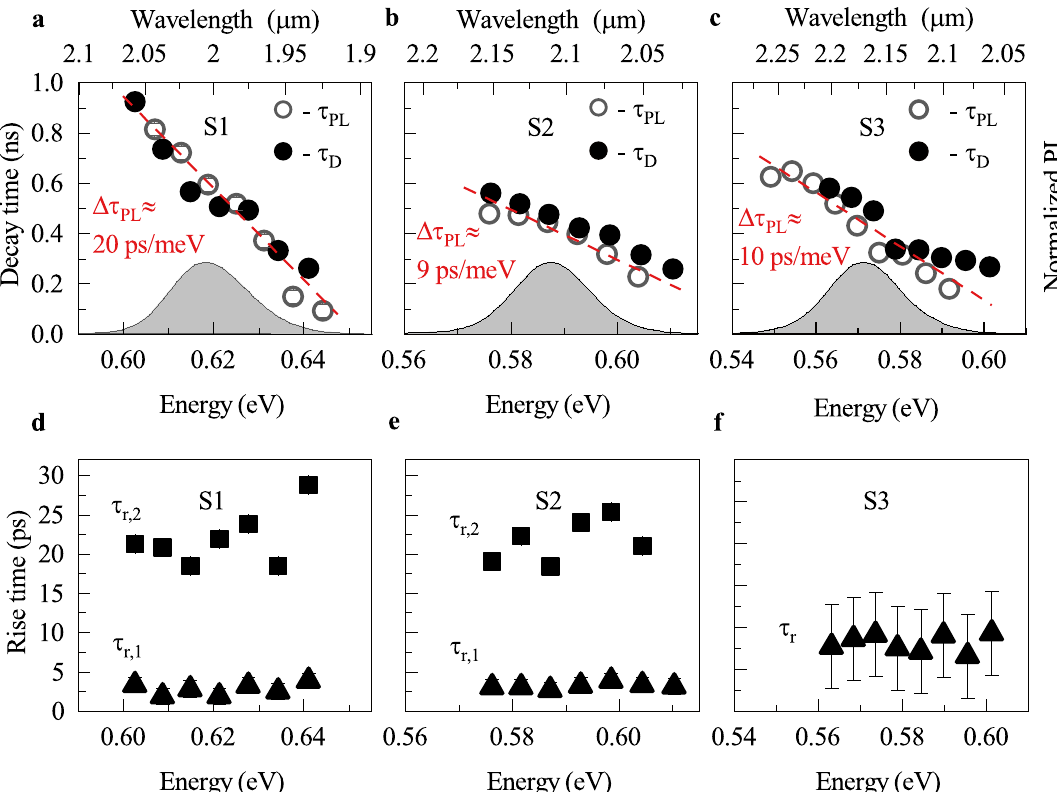
Figure 5. ( a )–( c ) Extracted decay time constants from TRPL (open circles) and TR traces analysis (black points) for (Ga,In)(Sb,Bi)/GaSb QWs with the Bi content of 6%, 7%, and 8%, respectively. Grey shaded presents normalized PL spectrum. ( d )–( f ) Extracted rise time constants from the TR curve analysis. T = 4.2K